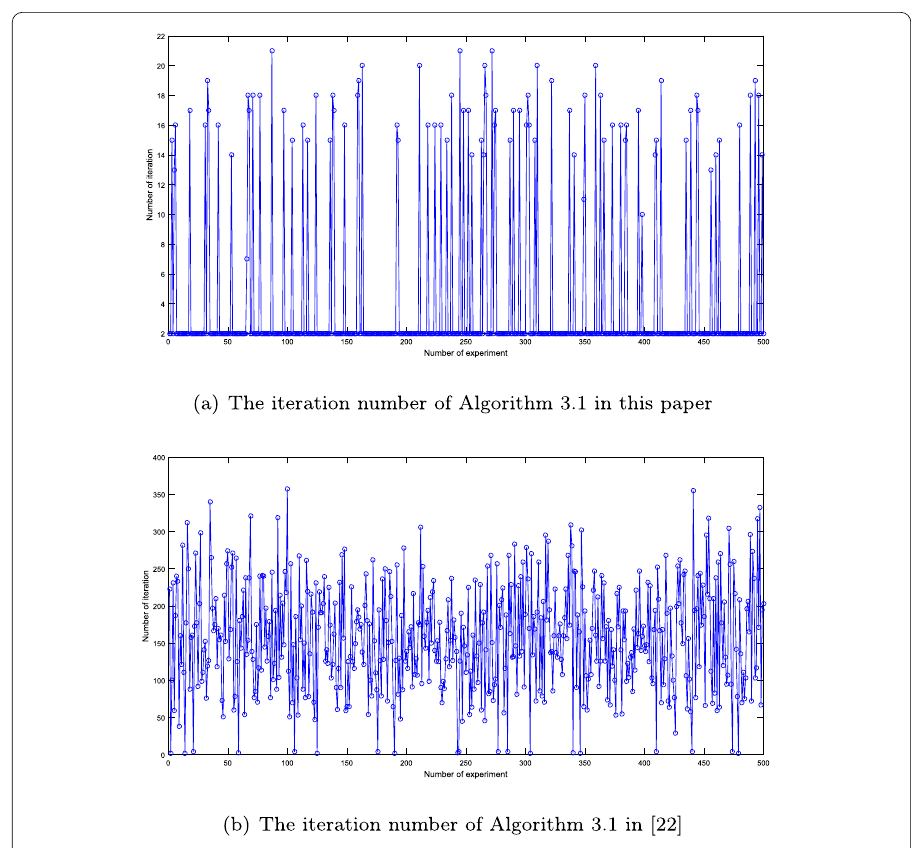
Figure 2 The iteration number of Algorithm 3.1 in this paper and Algorithm 3.1 in